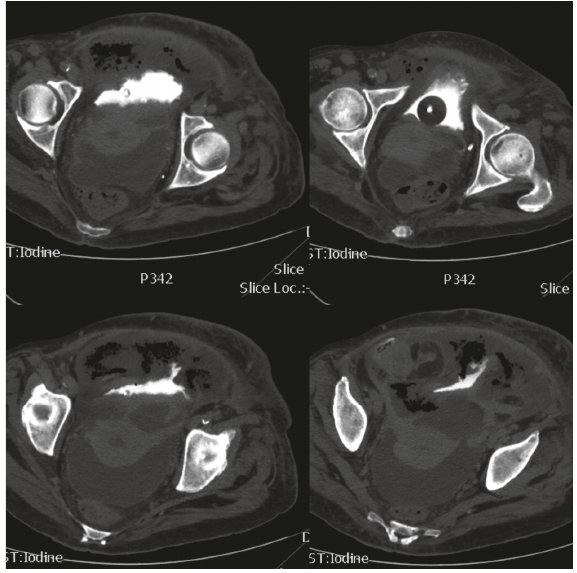
Figure 3: CT cystography revealed extravasation of contrast solu- tion in the peritoneal cavity.